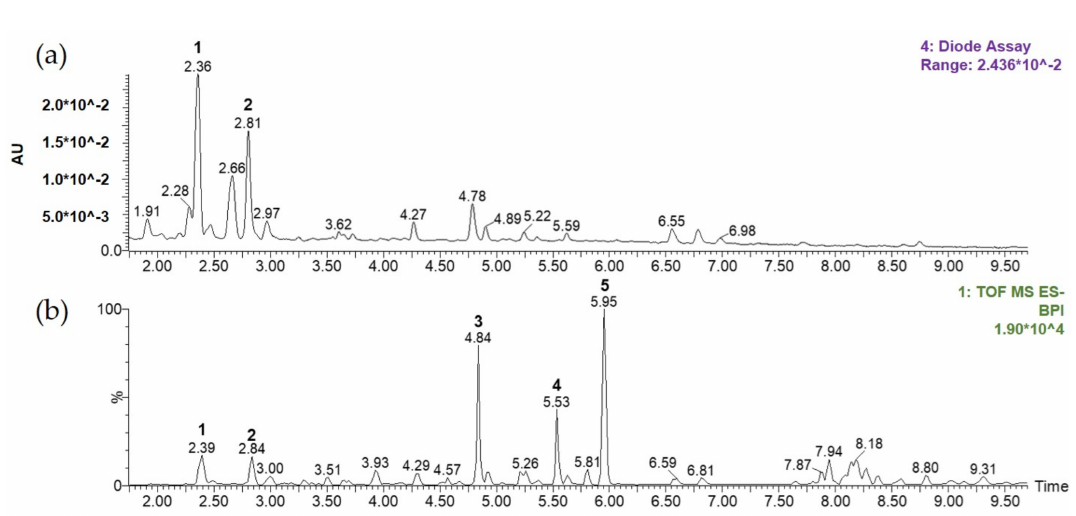
Figure 2. Representative chromatograms of the 70% ethanol extract from the Siraitia grosvenorii residual extract (NHGR): ( a ) Photodiode array (PDA) chromatogram and ( b ) total ion current-base peak intensity (TIC–BPI)